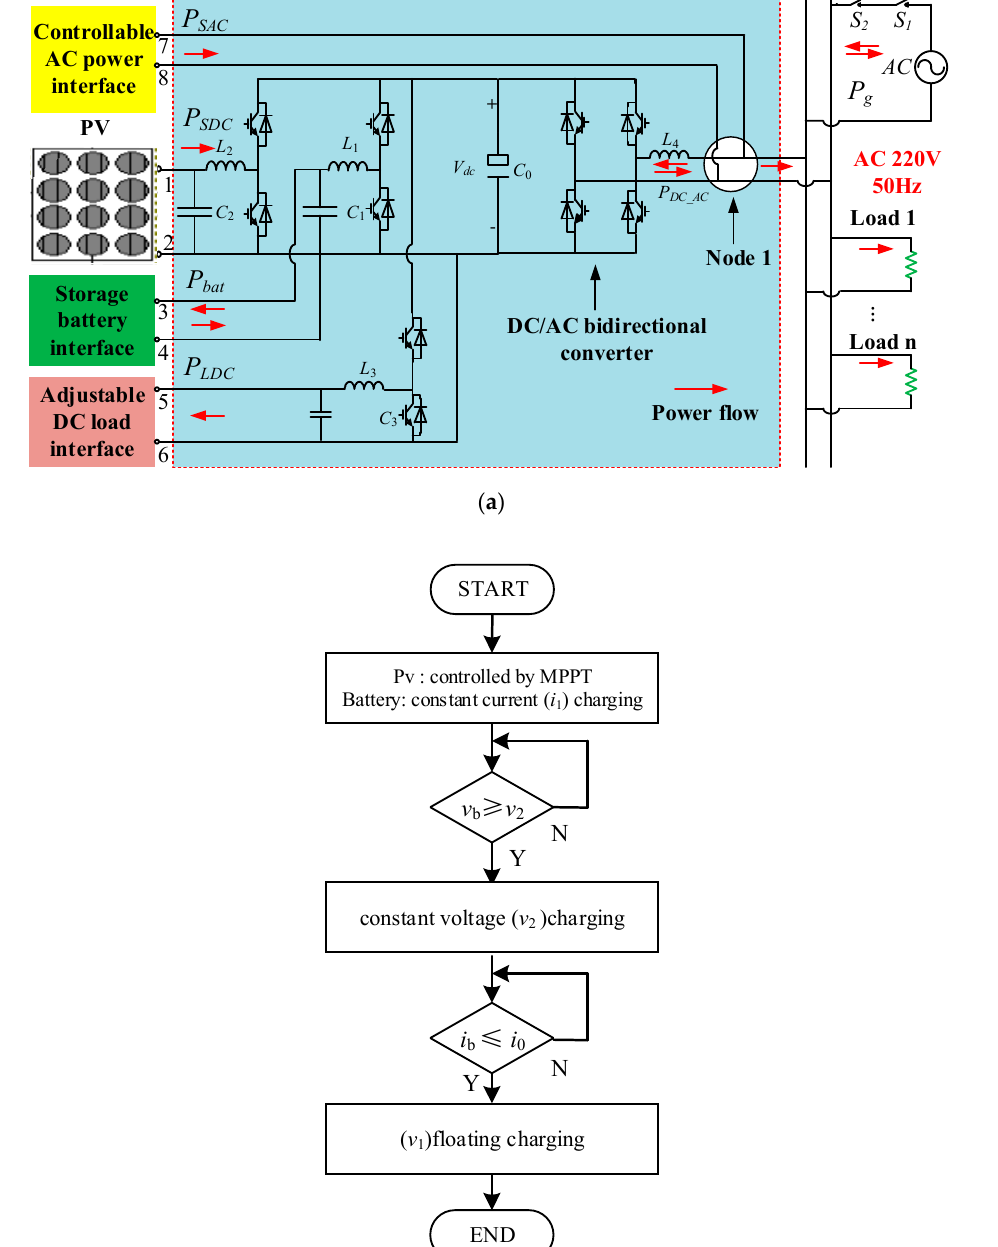
Figure 15. SPEERs are connected to the grid: ( a ) power flow chart; ( b ) control flow chart.